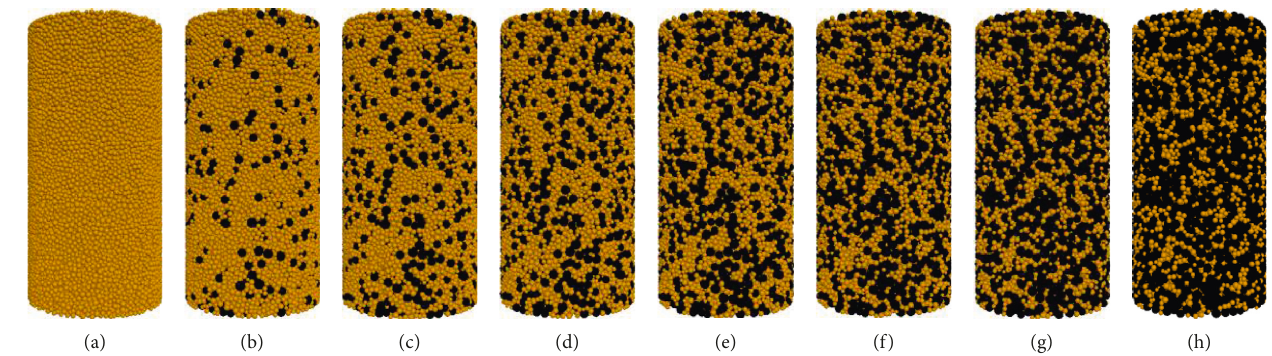
Figure 6: Numerical models of CRC with different rubber mass fraction. (a) 0% rubber. (b) 5% rubber. (c) 10% rubber. (d) 15% rubber. (e)